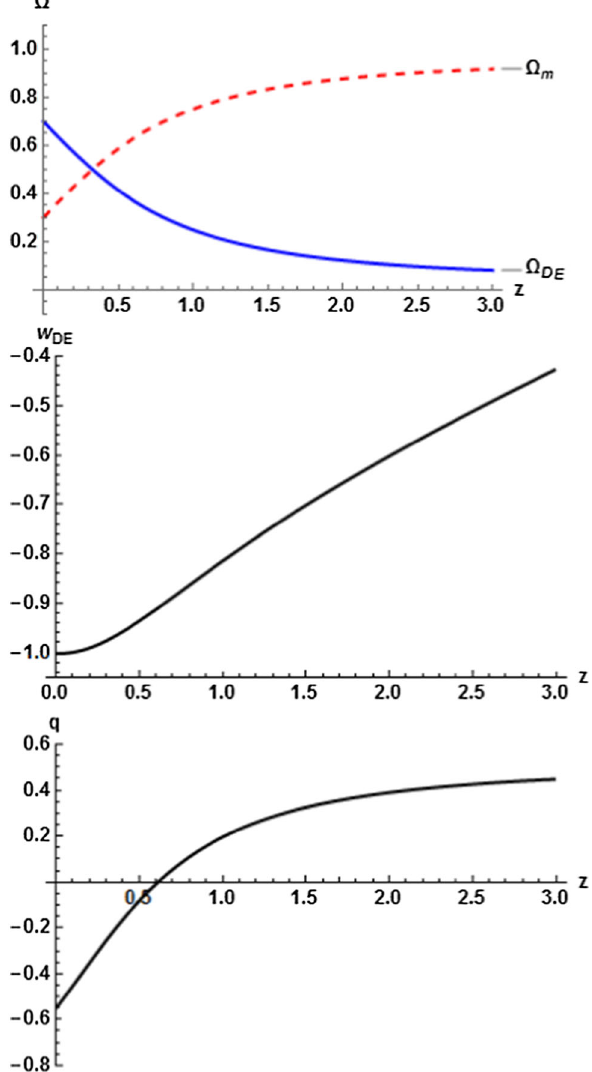
Fig. 1 Upper graph: The power-law holographic dark energy density parameter (cid:7) DE (blue-solid) and the matter density parameter (cid:7) m (red- dashed), as a function of the redshift z , for Model 1, for γ = 0 . 4 and = c = ¯ h = M = 1. Middle graph: The C 1 = 0 . 4 in units where k p B corresponding dark-energy equation-of-state parameter w DE . Lower graph: The corresponding deceleration parameter q . In all graphs we have imposed (cid:7) DE ( x = − ln ( 1 + z ) = 0 ) ≡ (cid:7) DE 0 ≈ 0 .